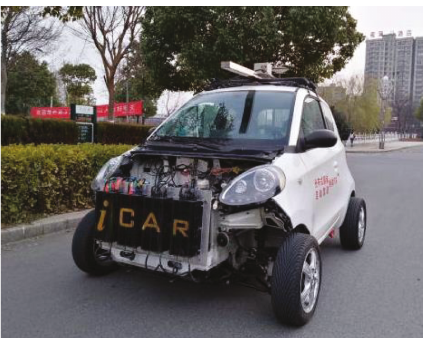
Figure 20: Test vehicle of UJS.